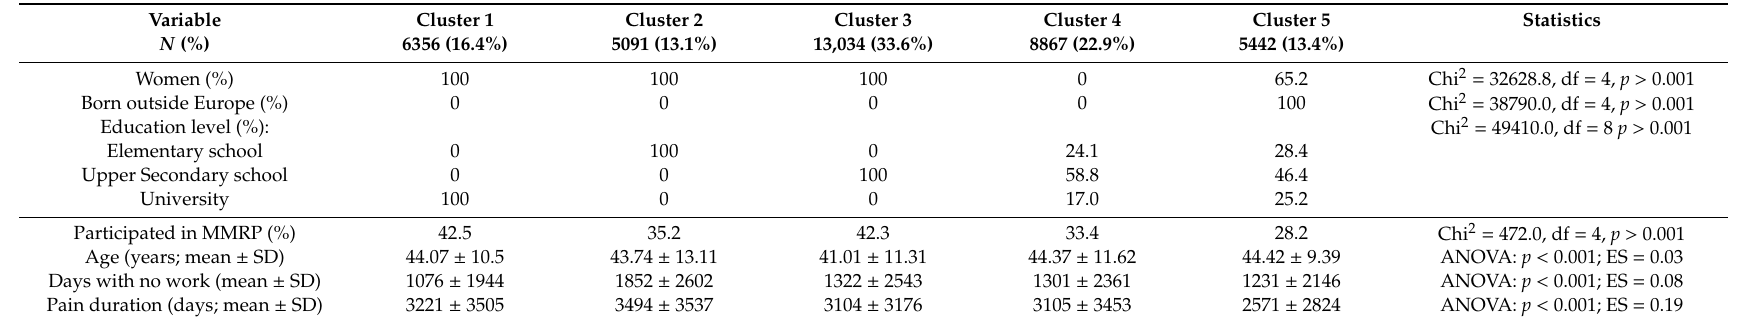
Table 7. Input variables (in bold type) together with cluster sizes for the five identified clusters. In the lower part of the table are the proportions participating in IMMRP, age, number of days with no work, and pain duration. Chi 2 and ANOVA are to the far right. For age, number of days with no work, and pain duration are given e ff ect sizes (ES, Hedges’g) for cluster 1 vs. cluster